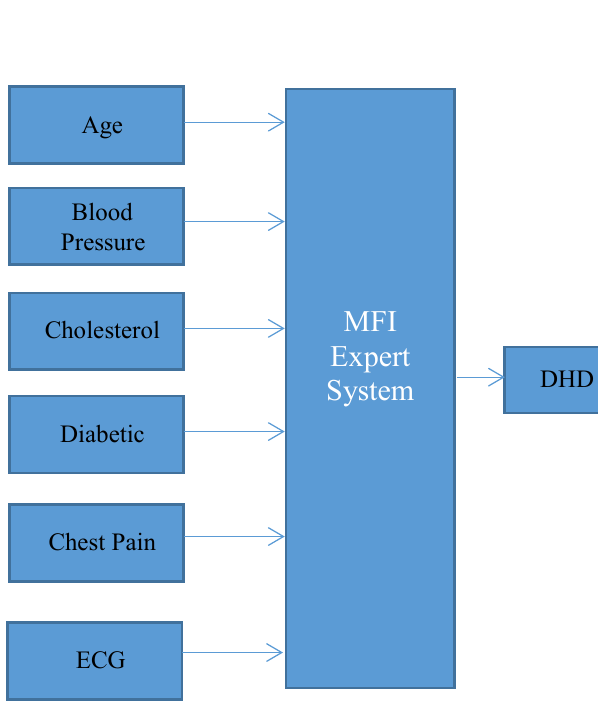
Fig. 1. Proposed DHD-MFI